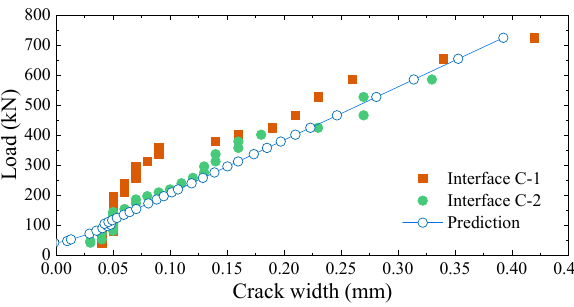
Figure 15. Prediction value and test results of joint interface crack width.